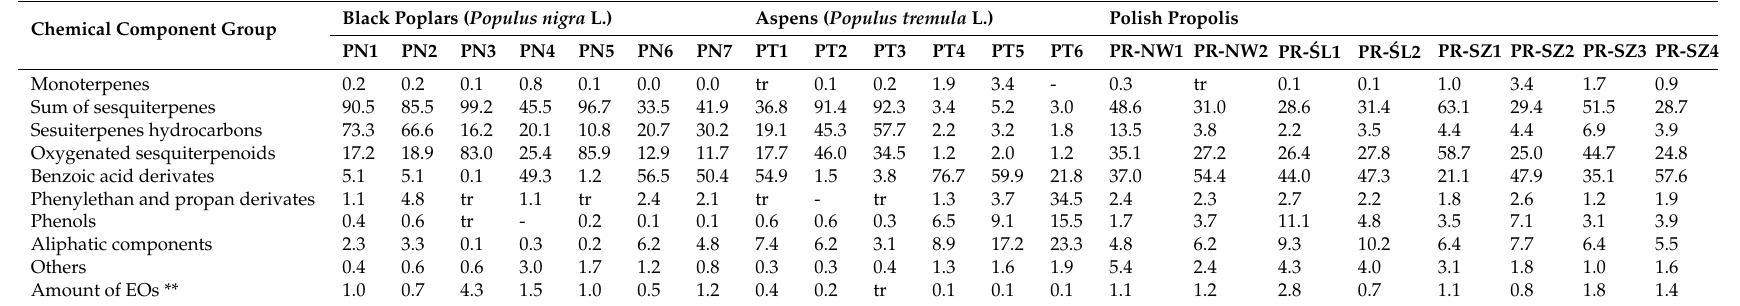
Table 3. General composition of Populus spp. buds and Polish propolis essential oils *. Chemical Component Group